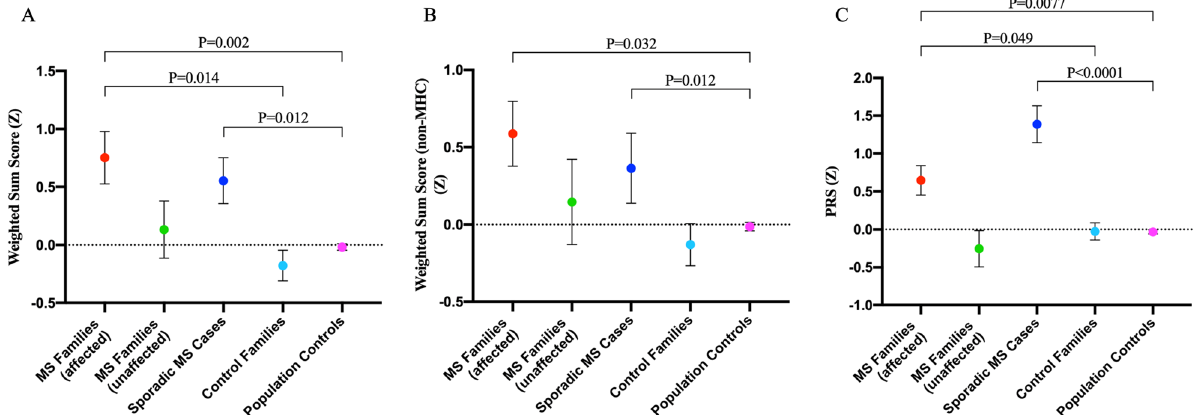
Figure 3. Weighted sum scores and polygenic risk scores (PRS) are higher in the affected members of MS families compared with the control families and healthy population controls. (A) Comparisons of weighted sum scores that include both MHC and non-MHC alleles among the study groups. (B) Comparisons of weighted sum scores that include only non-MHC alleles among the study groups. (C) Comparisons of PRS values among the study groups. Logistic regression analysis. Data are mean ± s.e.m. P < 0.05,